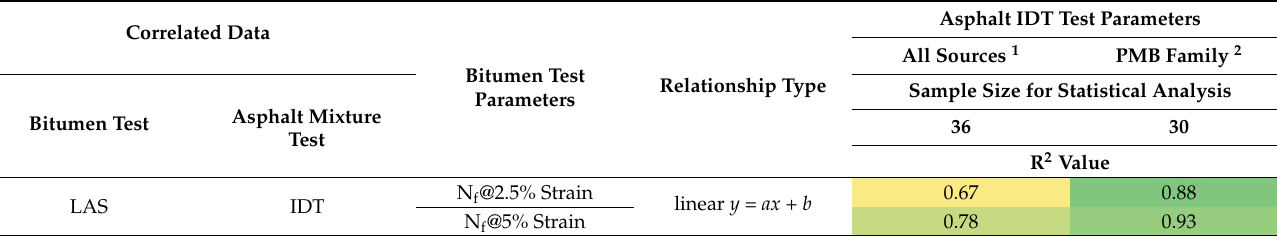
Table 7. Pearson coefficients of determinations between binders LAS and asphalt mixtures IDT@25 ◦ C. (Green Background = Moderate to High Correlation (Darker Green = Higher Correlation Compared to Lighter Green); Yellow Backgound = Average